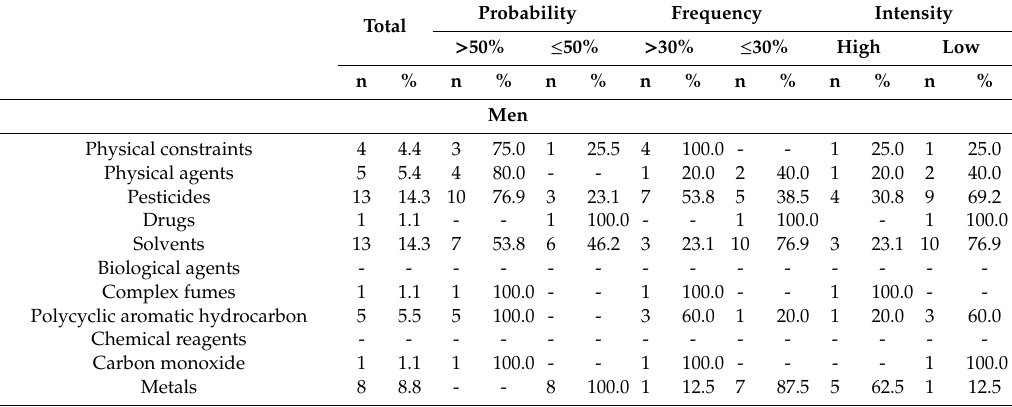
Table 3. Occupational exposure reported on the day of consultation for employed patients seen in interviews at the ARTEMIS center from 16 February 2016 to 2 May 2019 (n = 91 employed men and 488 employed